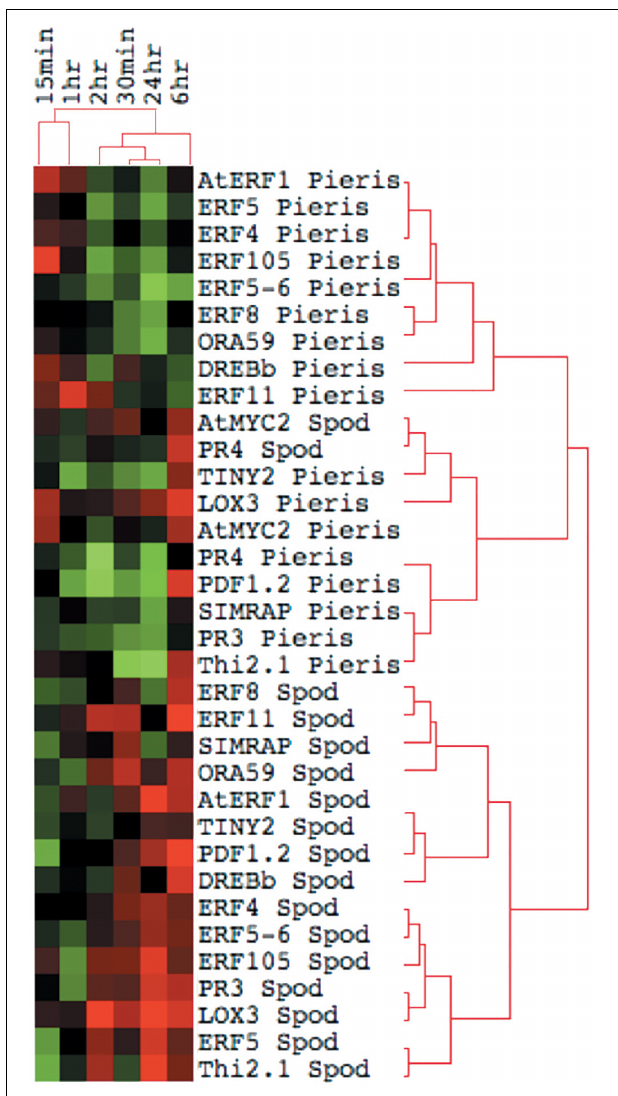
FIGURE 5 | Cluster Analysis and Heat Map of Defense-Related Gene Expression by P. rapae vs. S. exigua . Gene expression values in Arabidopsis tissue after insect treatments were and clustered by time after feeding using the method described by Eisen et al. (1998). Red color indicates the up-regulation of a gene, while green shows down-regulation. A black box represents no change in